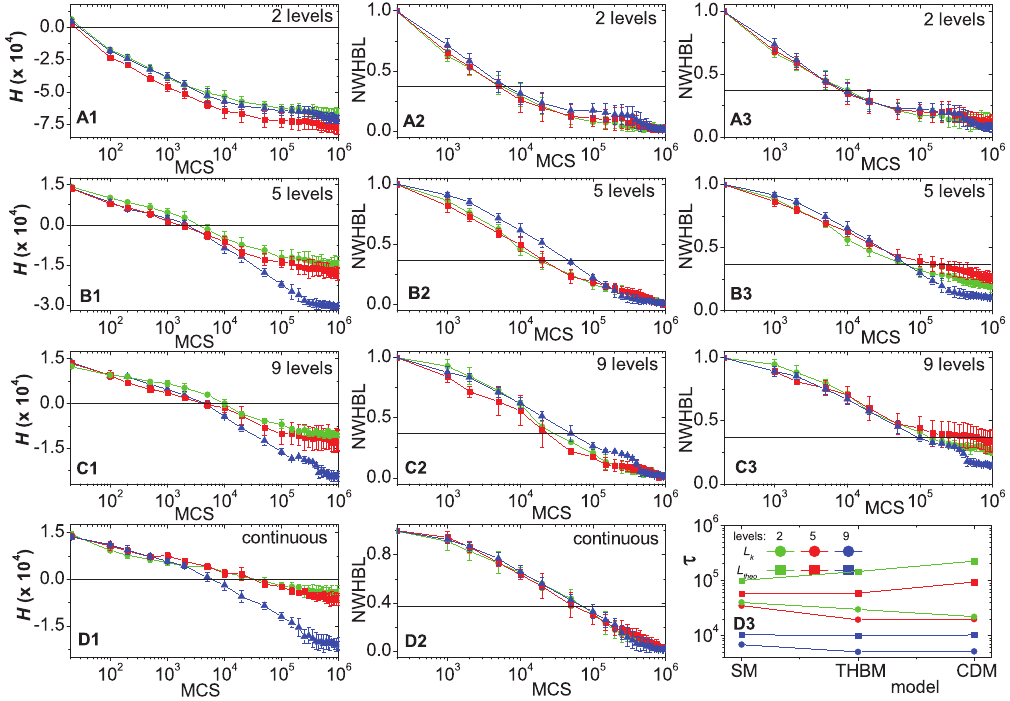
Figure 5. Evolution of the effective energies (H) and normalized weighted heterotypic boundary lengths (NWHBL) for aggregates N with 2, 5, 9 or continuous cadherin levels using CDM, THBM or SM for the same expression range [1, 23]. In ( A1 ) – ( A3 ), ( B1 ) – ( B3 ), ( C1 ) – – THBM; Blue lines m – SM. In ( A2 ), ( A3 ), ( B2 ), ( B3 ) and ( C2 ) – ( C4 ), the time at which the ( C3 ), and ( D1 ) – ( D2 ), Red lines & – CDM; Green lines heterotypic boundary length of a given simulation crosses the horizontal black line is defined as its relaxation time. In ( A2 ), ( B2 ), ( C2 ) and ( D2 ) L min ~ L k . In ( A3 ), ( B3 ) and ( C3 ) L min ~ L theo . ( A1 ), ( B1 ), ( C1 ) and ( D1 ) Evolution of the H for aggregates with cells expressing 2, 5, 9 and continuous cadherin levels respectively. ( A2 ), ( B2 ), ( C2 ) and ( D2 ) Evolution of NWHBL for the aggregates in ( A1 ), ( B1 ), ( C1 ) and ( D1 ), respectively, with L min ~ L k . ( A3 ), ( B3 ) and ( C3 ) Evolution of the NWHBL for the aggregates in ( A1 ), ( B1 ) and ( C1 ) respectively, with L min ~ L theo . ( D3 ) Relaxation time vs. bond model for different cadherin expression levels. Blue – 2 levels; Red – 5 levels; Green – 9 levels. Circles – L min ~ L theo . Squares – L min ~ L k . The error bars in the graphs are calculated from ten simulation replicas.